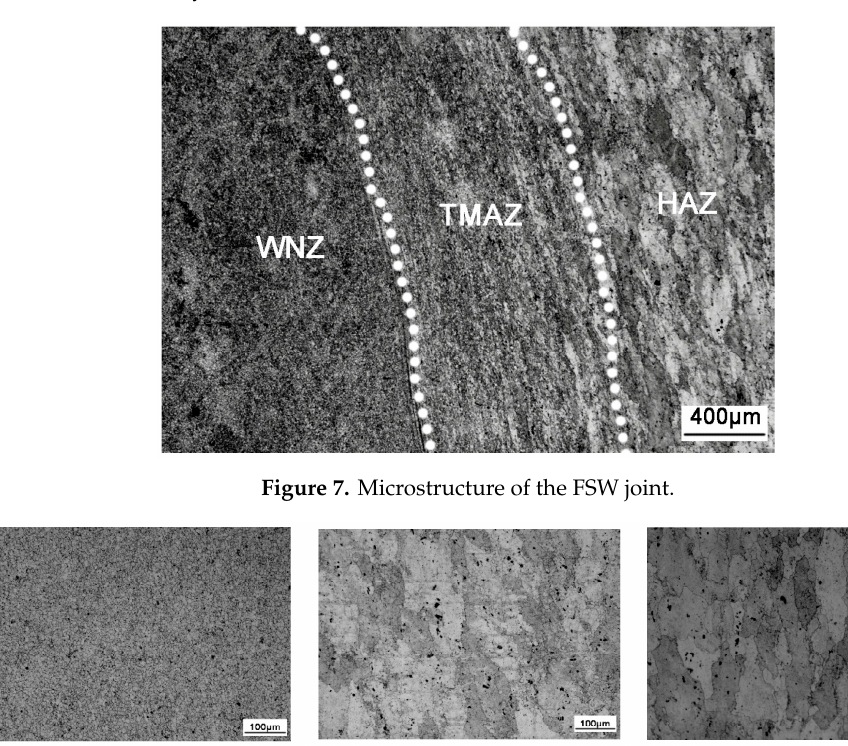
Figure 6. Macrostructure along the cross-section of the FSW: ( a ) weld nugget zone (WNZ); ( b ) thermomechanically affected zone (TMAZ); ( c ) heat-affected zone (HAZ); ( d ) base metal zone.